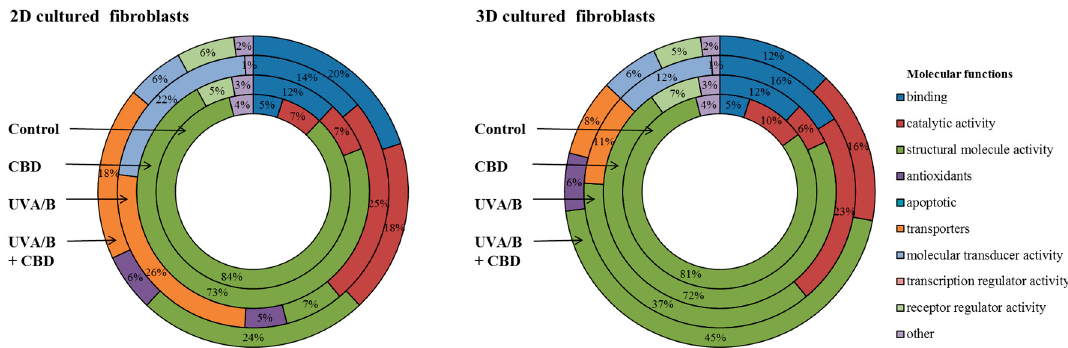
Figure 6. The molecular functions of proteins modified by lipid peroxidation products (malondialdehyde (MDA), 4-hydroxynonenal (4-HNE), acrolein) adducts formation in fibroblasts irradiated with UVA (20 J / cm 2 ) and UVB (200 mJ / cm 2 ) or / and treated with cannabidiol (CBD, 4 µ M) in two-dimensional (2D) or three-dimensional (3D) culture